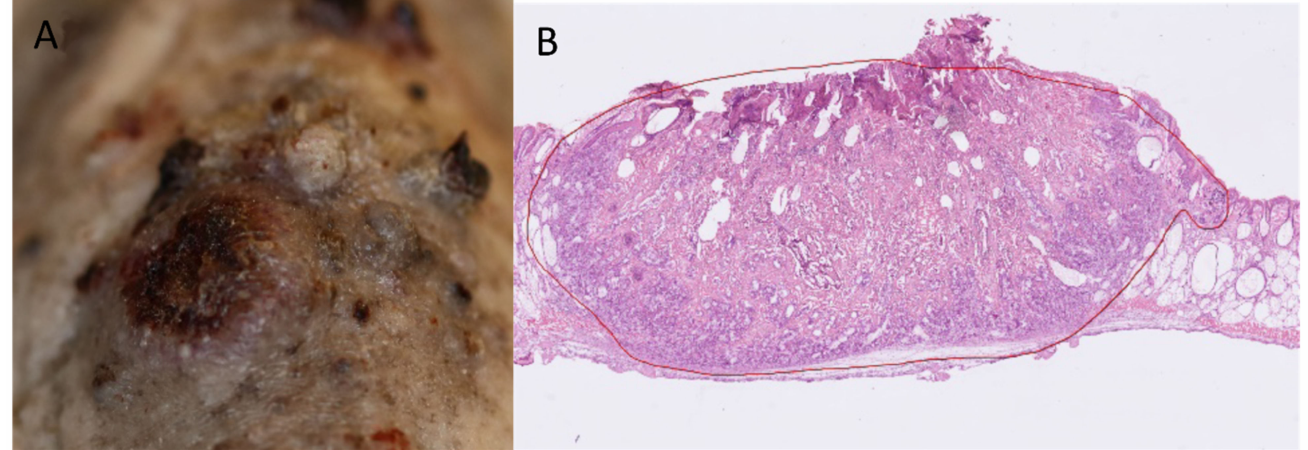
Figure 3. ( A ) Clinical photo of a representative tumor. ( B ) Tumor histology showing squamous cell carcinoma (stained with hematoxylin and eosin). Table 1. Treatment schedule and results. Median number of days to onset of the first, second, and third tumors in 50% of the mice in each of the four groups. Interquartile ranges (25th and 75th percentiles) are shown. Group